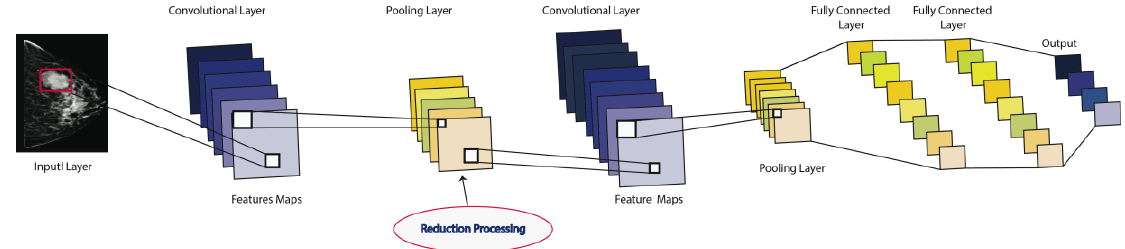
Figure 7. A feed-forward CNN network, where the convolutional layers are the main components, followed by a nonlinear layer (rectified linear unit (ReLU)), pooling layer for feature map extraction, loss function (softmax), and the fully connected layers for classification. The output can be either benign or malignant classes.